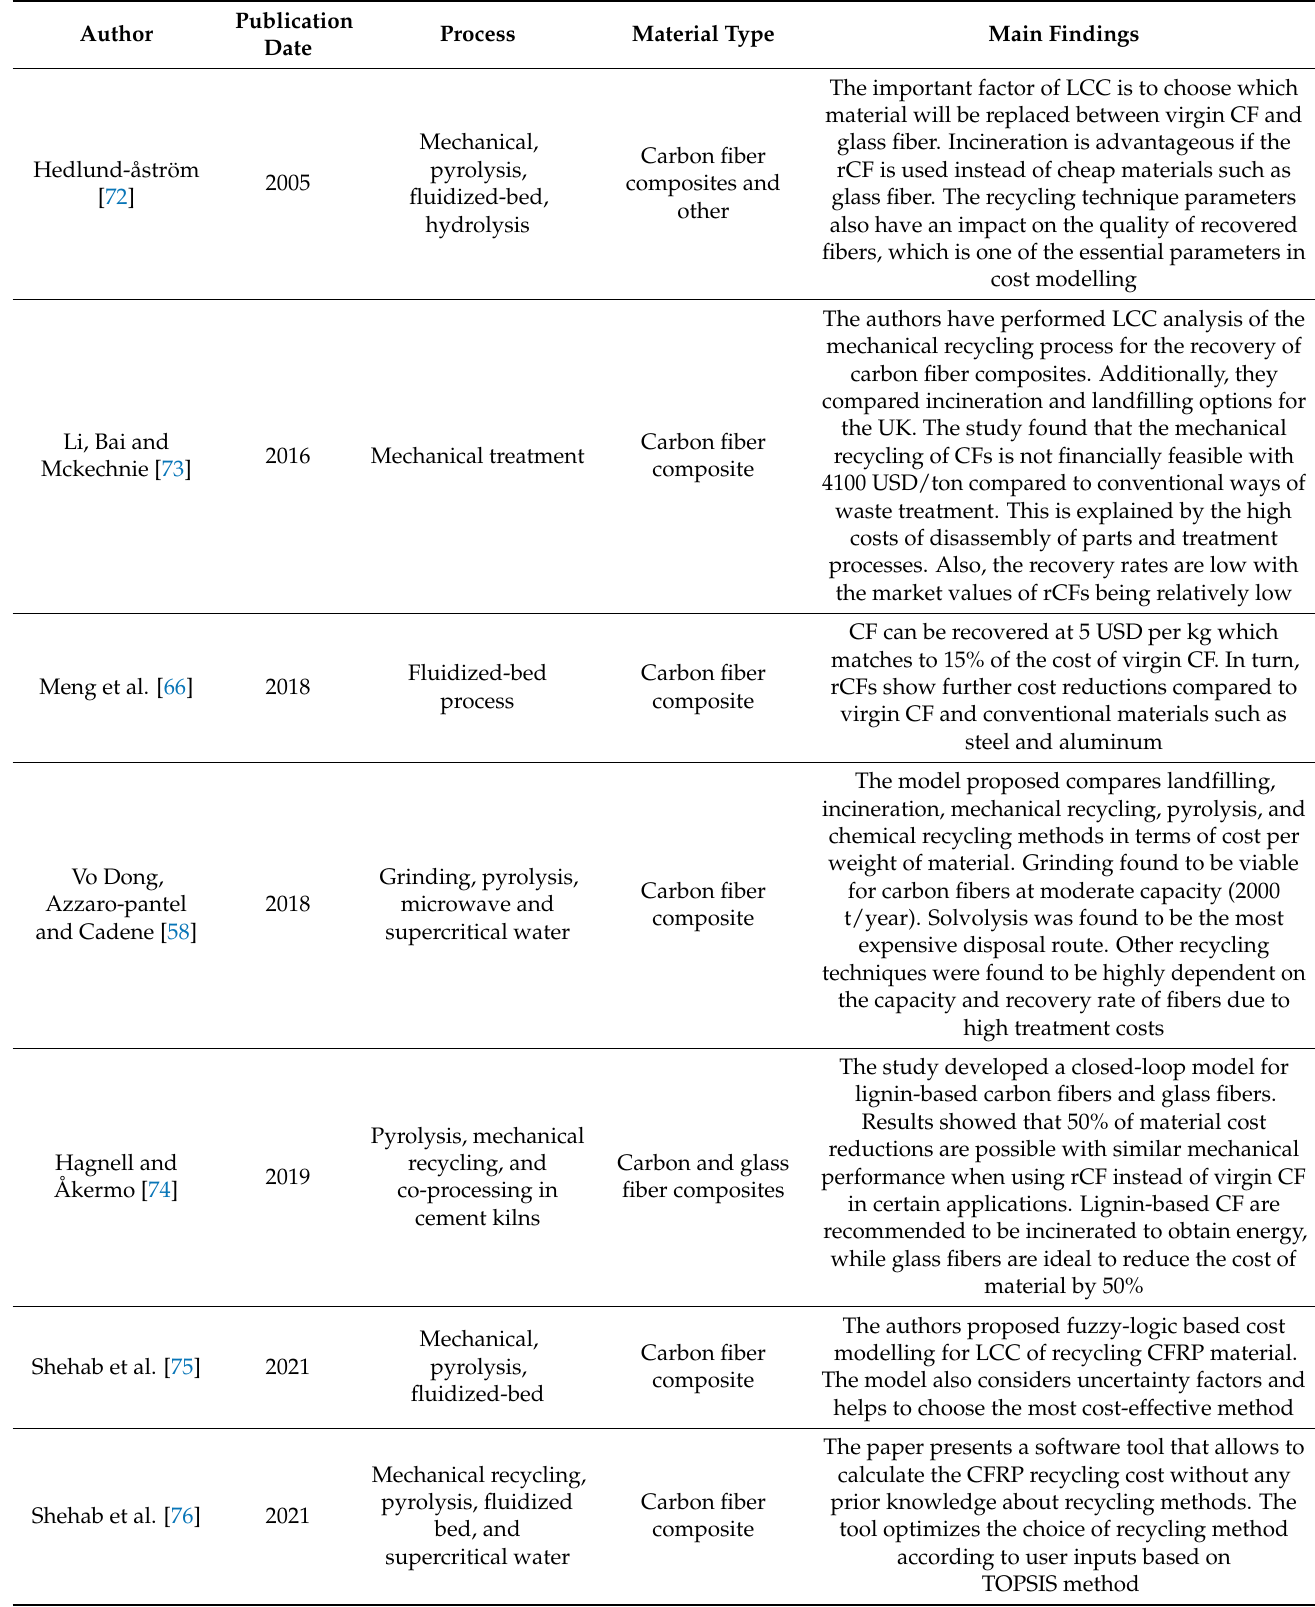
Table 2. Recent studies on cost modelling for composites